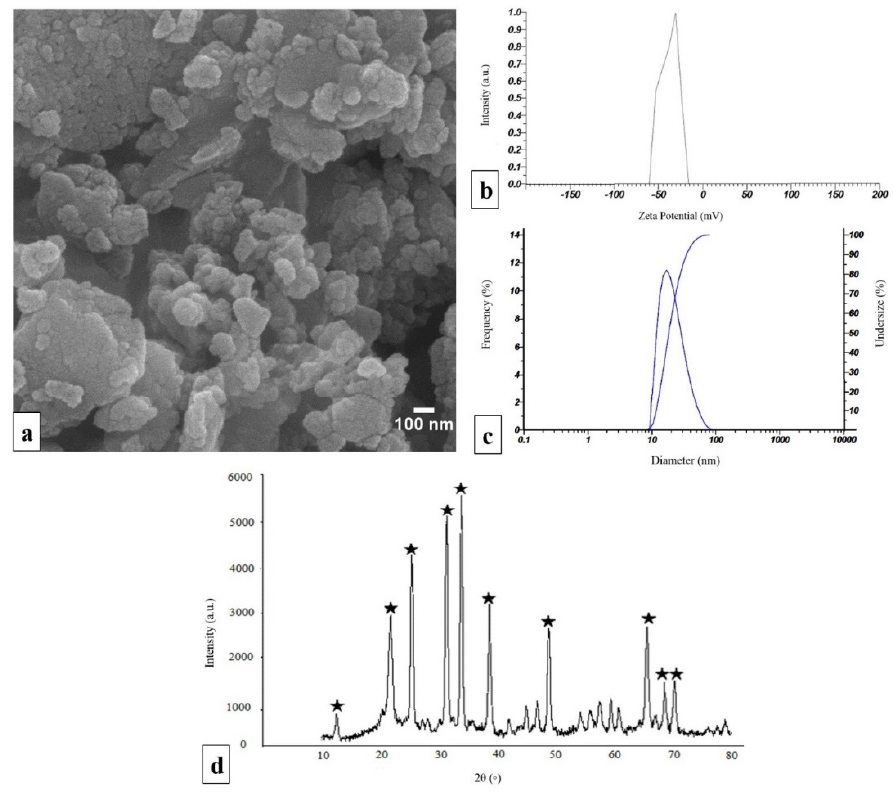
Figure 1. npW characterization. ( a ) Morpho-structural characterization of nanoparticles obtained from SEM microscope, ( b ) particle size distribution in the range of 10 to 100 nm by DLS analysis, ( c ) the zeta potential under the applied analysis conditions resulted in a value of − 36 mV, ( d ) XRD spectrum of npW reveals the signals at 2 θ values marked with asterisks.